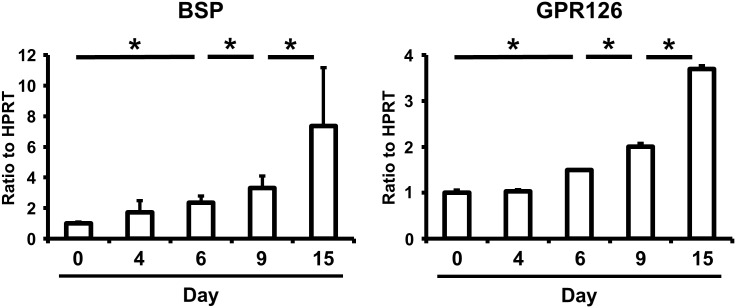
Expression of GPR126 during the cytodifferentiation of HPDL cells.HPDL cells were transfected with empty vector and incubated with mineralization medium for 4, 6, 9, and 15 days and the expression of BSP and GPR126 was assessed by real-time PCR. Data represent the average and standard deviation of four independent experiments. *p <0.05.